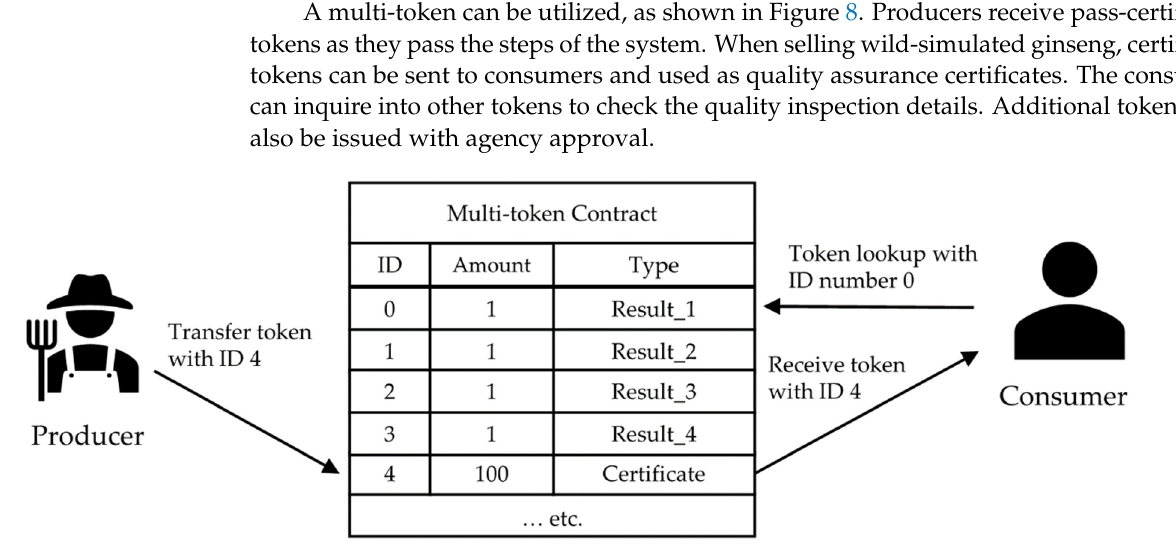
Figure 8. Quality management using multi-token.